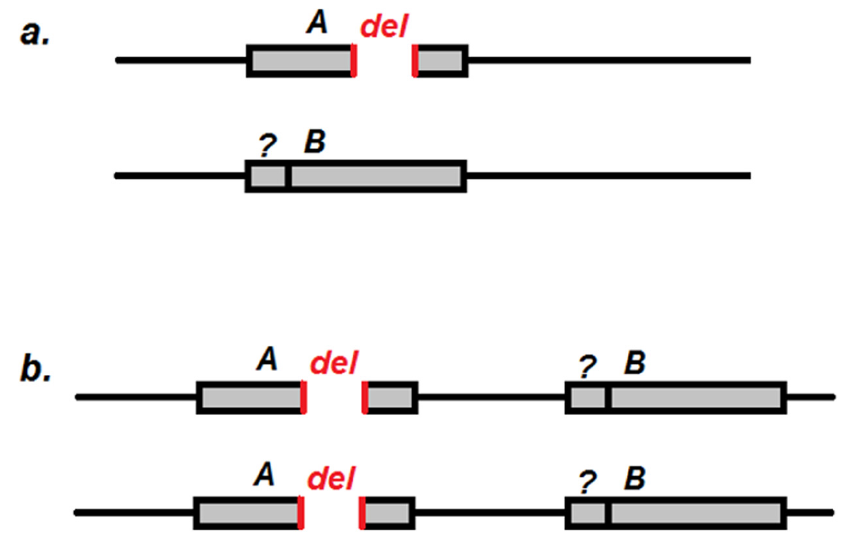
Figure 9. Possible arrangement of different cd copies in the genome of cd 1 flies. Grey rectangle is either cd (case a ) or cd followed by Cyp6d4 (case b ). A and B —two variants of cd ; del— deletion; ?—the presumable alterations within cd ( B ) 5 ′ area.